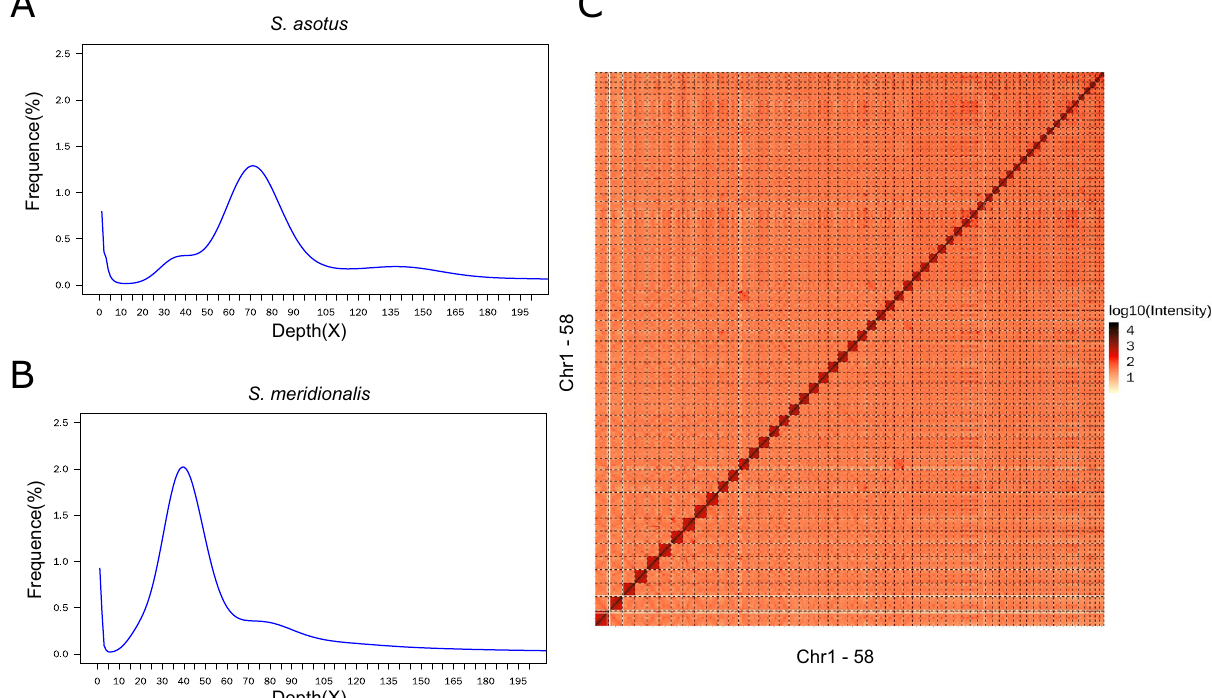
Figure 1. Assembly features of the hybrid genome. (A, B ) 17-mer distributions deduced using short reads from non-hybrid individuals for the parental species S. asotus and S. meridionalis , respectively. ( C ) The heatmap of interactions between any two regions across the chromosomes residing in the somatic cells of the hybrid individual estimated based on the Hi-C sequencing Division of the hybrid genome. The assembly of the hybrid genome was divided and assessed separately. The genomic short reads for each of the non-hybrid individuals of the two parental species were mapped back to the assembly, and the chromosomes from S. asotus and S. meridionalis were recognized based on the mapping depth and coverage as defined in Samtools (Fig. 2). Using samtools, the proportion of covered bases and the mean depth of coverage were summarized and termed coverage and meandepth, respectively. When the short reads of S. asotus were mapped back, nearly all of the regions of 29 chromosomes are highly covered, but for the other 29 chromosomes, the depth decreased sharply, and the coverage were declined, too. Thus, we were able to identify the chromosomes from the two species. When the short reads of S. meridionalis , the situation was similar (Fig. 2). The assembly sizes for S. asotus and S. meridionalis were 744.12 Mb and 748.79 Mb, represent- ing 94.0% and 96.0% of the estimated genome sizes, respectively (Table 1). BUSCO assessments suggested that more than 95% of the genes were single copy and complete, and less than 1% were missing for each of the two species (Fig. 2). The contig N50 lengths were 6.75 Mb and 9.78 Mb for S. asotus and S. meridionalis , respectively. The high completeness and continuity, as well as the high mapping rates of the genomic short-reads from the